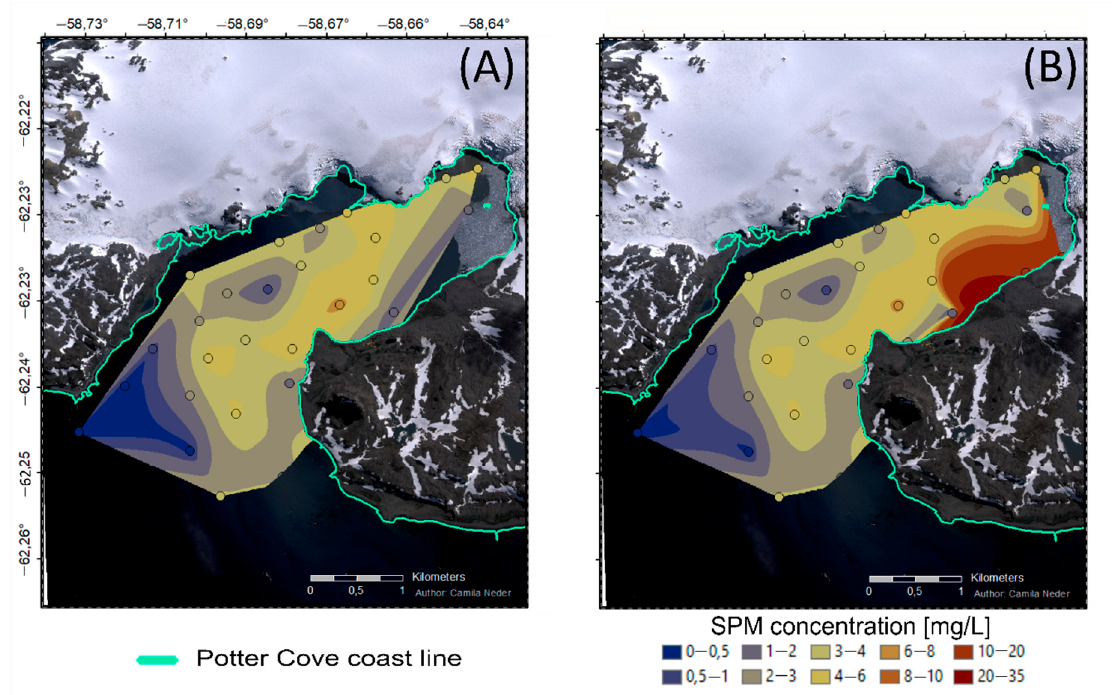
Figure 5. Natural neighborhood interpolation for ( A ) one-day SPM data without meltwater streams SPM concentration inputs data ( B ) with meltwater streams discharges. The SPM concentration is interpolated to generate a surface raster based on the determination of the natural neighbors based on an overlap of Voronoi polygons and a new polygon around an interpolation point.